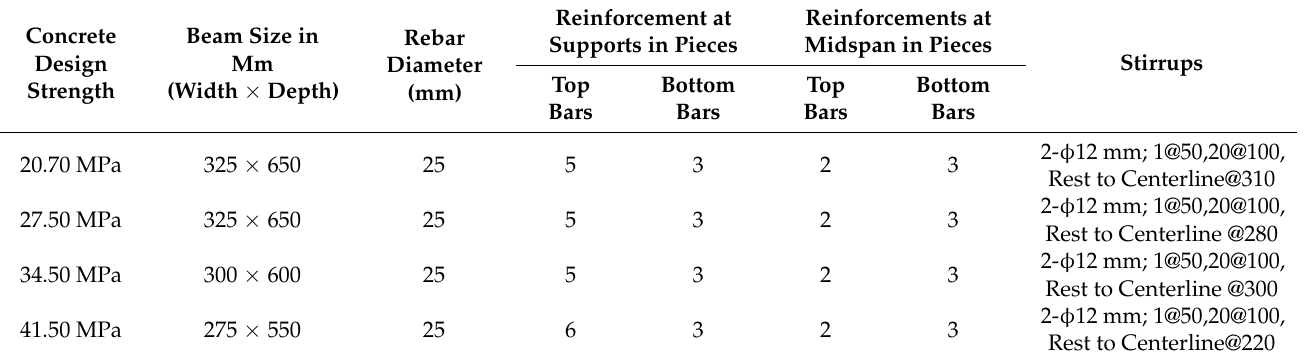
Table 7. Seven-story building beam sizes and